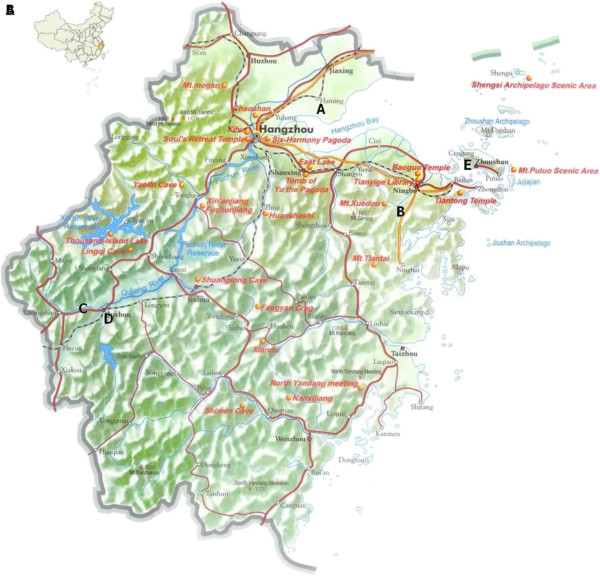
The Map of Zhejiang Province. A, B, C, D, and E were the five districts we chosen. A: eastern rural district. B: eastern urban district. C: western rural district. D: western urban district. E: island.